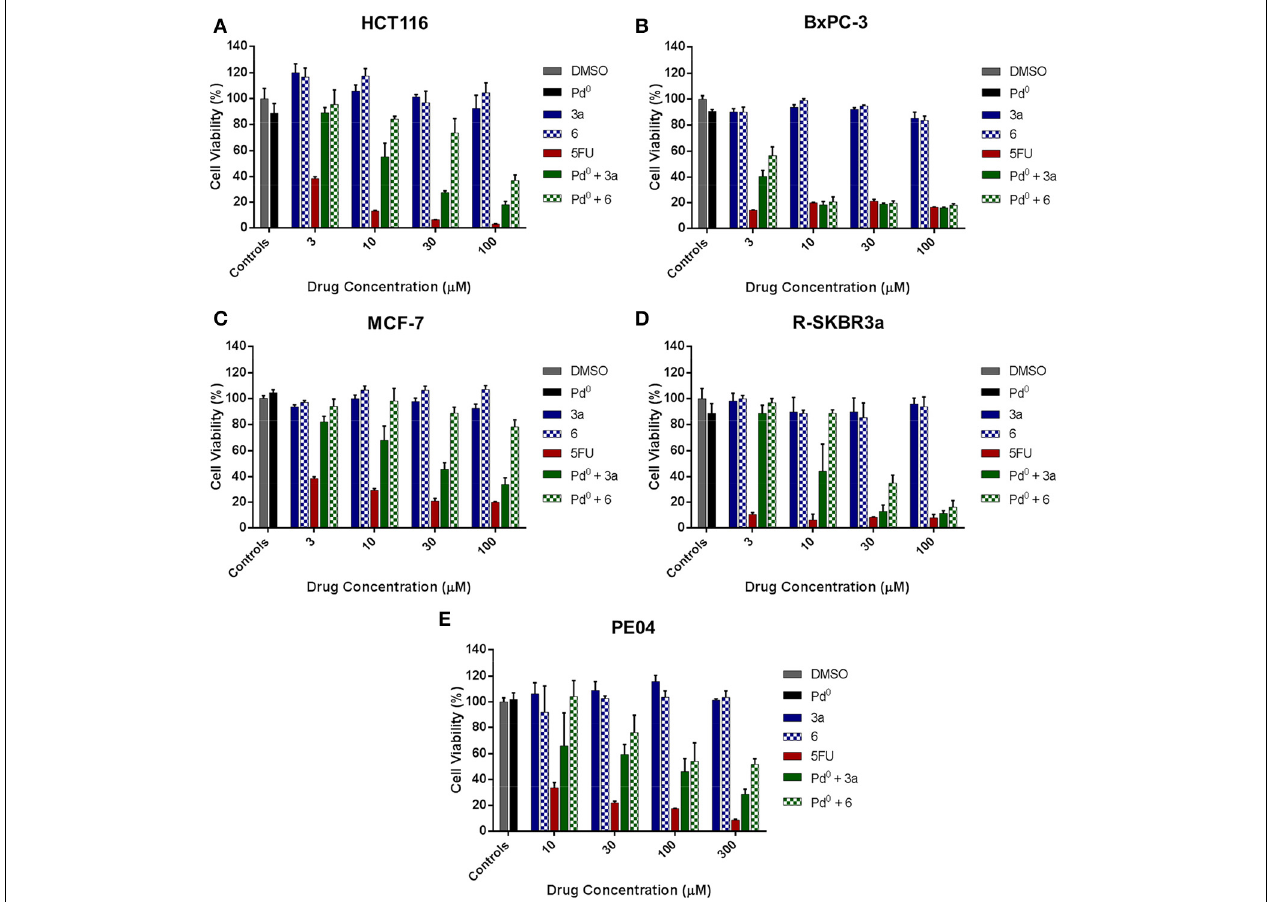
FIGURE 5 | Palladium-mediated conversion of prodrugs 3a and 6 into 5FU in cancer cell culture. (A) Colorectal cancer HCT116 cells; (B) Pancretic adenocarcinoma BxPC-3 cells; (C) Breast cancer MCF-7; (D) Breast cancer R-SKBR3a cells; (E) Ovarian carcinoma PE04 cells. Drug generation was indirectly measured by analysis of cell viability after 5